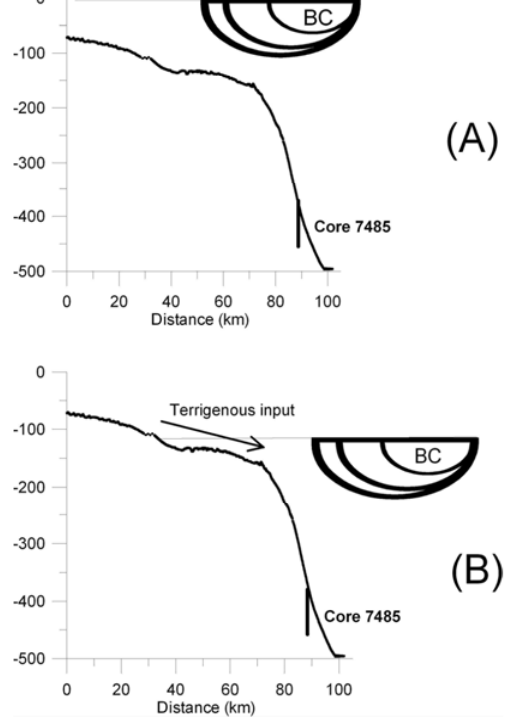
Fig. 7 – Schematic model for the position of the Brazil Current (BC) under different climatic conditions (a) Present and Isotope Stage 3 and (b) Last Glacial